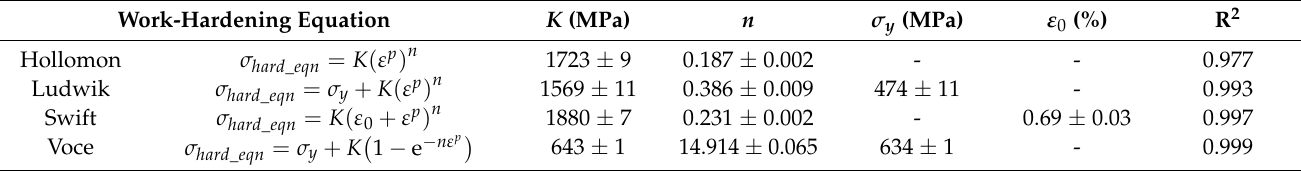
Table 3. Parameters of the work-hardening equations of the CR980XG3 TM steel sheet determined from the uniaxial tensile tests performed at the rolling direction.